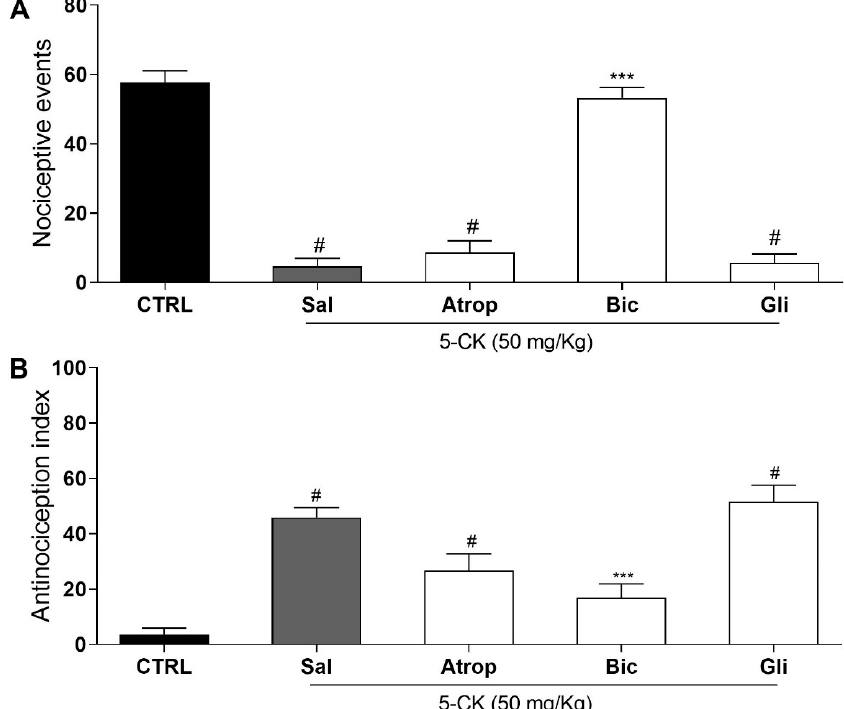
Figure 6. Assessment of possible mechanisms involved in the antinociceptive effect of 5-CK. Functional antagonism assays were performed on cold plate; and ( A ) tail flick; ( B ) tests using atropine (Atrop; 10 mg/Kg, 15 min before, cholinergic receptor antagonist), bicuculline (Bic; 1 mg/Kg, 15 min before, GABA A receptor antagonist) or glibenclamide (Gli; ATP- sensitive potassium channel blocker, 2 mg/Kg, 30 min before). Mice were treated by intraperitoneal routes with antagonists or saline (Sal) before the administration of 5-CK (50 mg/Kg) and 40 min afterward were submitted to nociceptive tests. The control group (CTRL) was treated with vehicle (50% propylene glycol in saline) by intraperitoneal route 40 min before the test. Data are expressed as means ± SEM; n = 6 mice per group. # Significantly different from CTRL group ( p < 0.05). *** Significantly different from Sal group ( p < 0.001). One-way ANOVA followed by Tukey’s test.